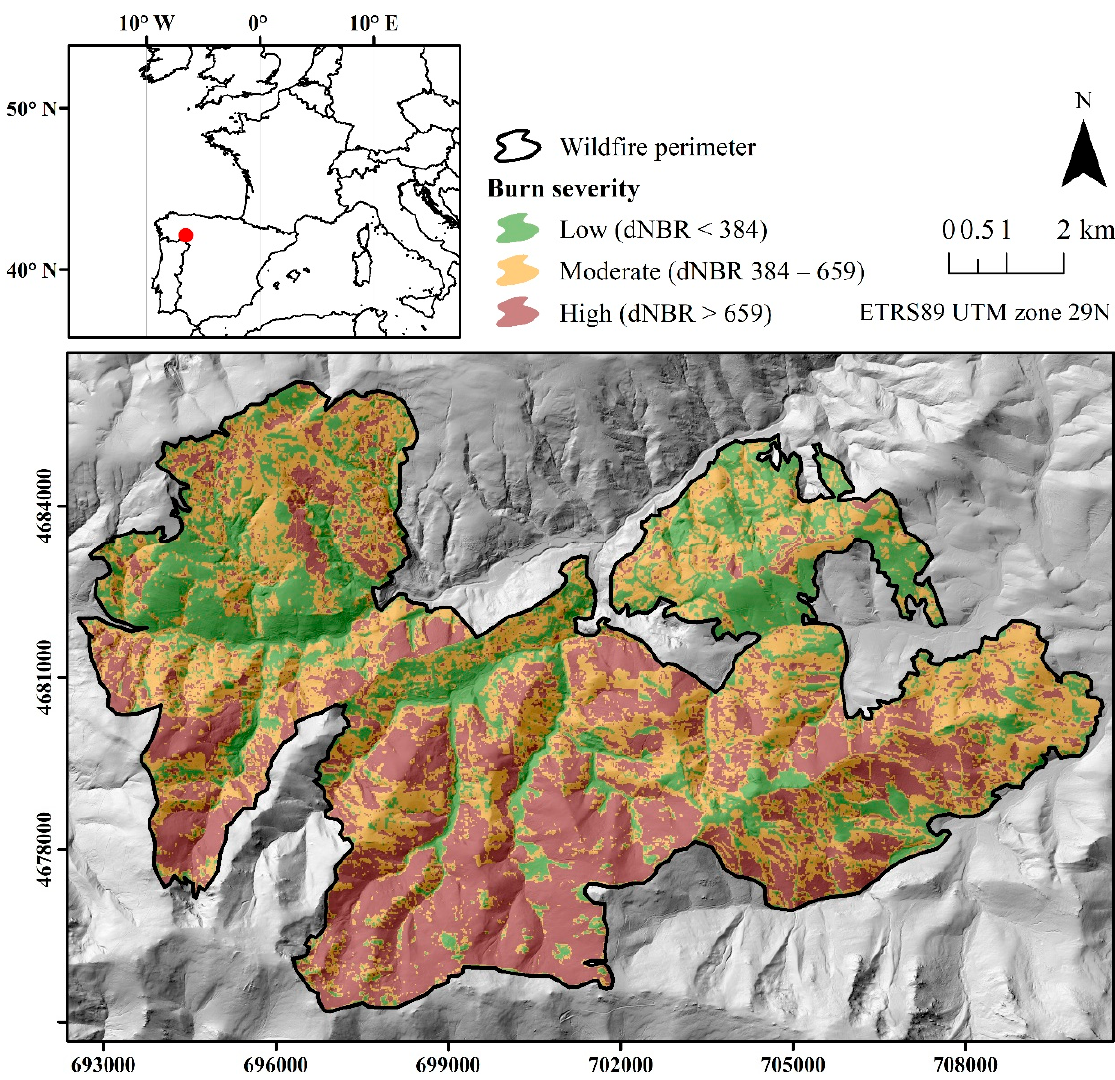
Figure 1. Wildfire perimeter and burn severity estimation from the differenced Normalized Burn Ratio (dNBR) thresholds.